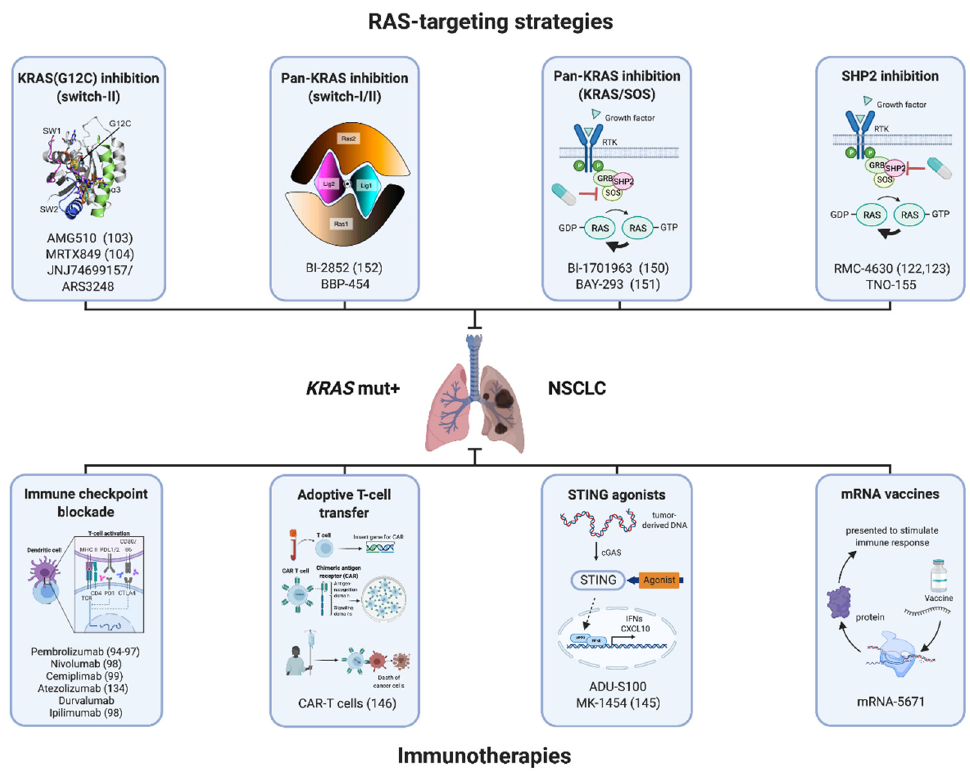
Figure 2. Overview of therapeutic concepts for patients with KRAS -mutant NSCLC in different stages of clinical development that target mutant KRAS itself or the surrounding tumor immune microenvironment. Future clinical trials are required to decipher the optimal strategy of simultaneously or sequentially combining these treatment strategies. References if applicable are displayed in brackets. Created with biorender.com (accessed on 3 March 2021).